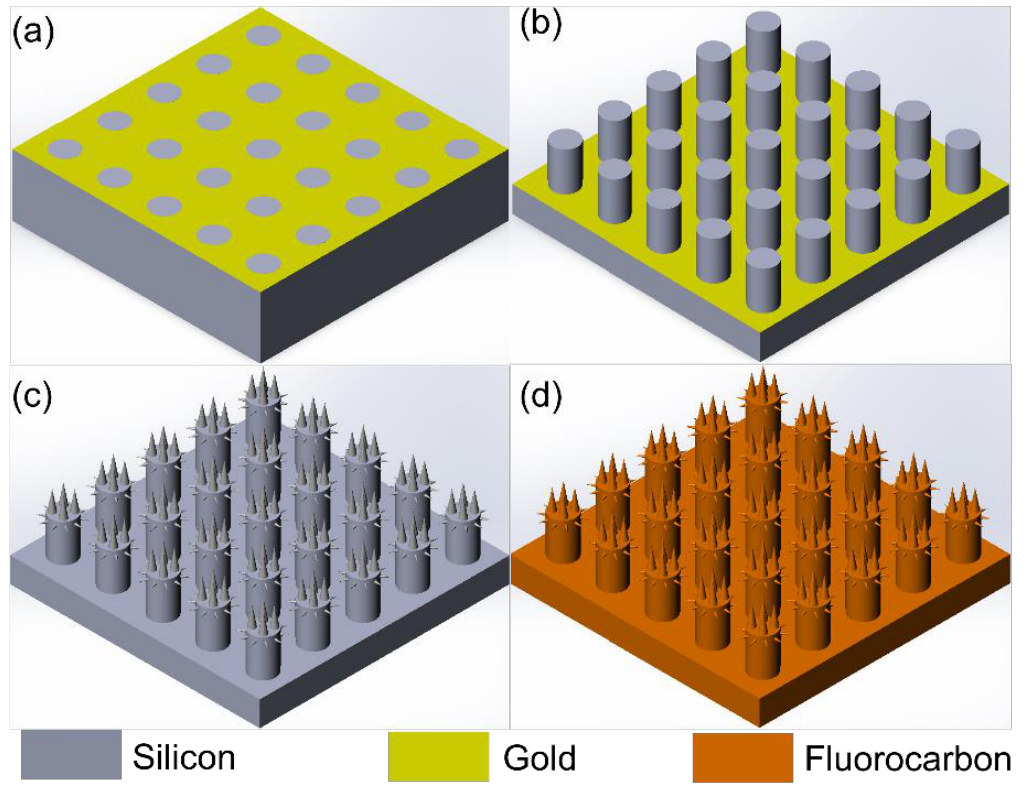
Figure 1. Schematic illustration of the major fabrication processes of hierarchical micro-/nanostructured surface. ( a ) UV photolithography, gold deposition, and lift-off process; ( b ) metal-assisted chemical etching for micropillars; ( c ) metal-assisted chemical etching for nanowires; ( d ) fluorocarbon deposition.